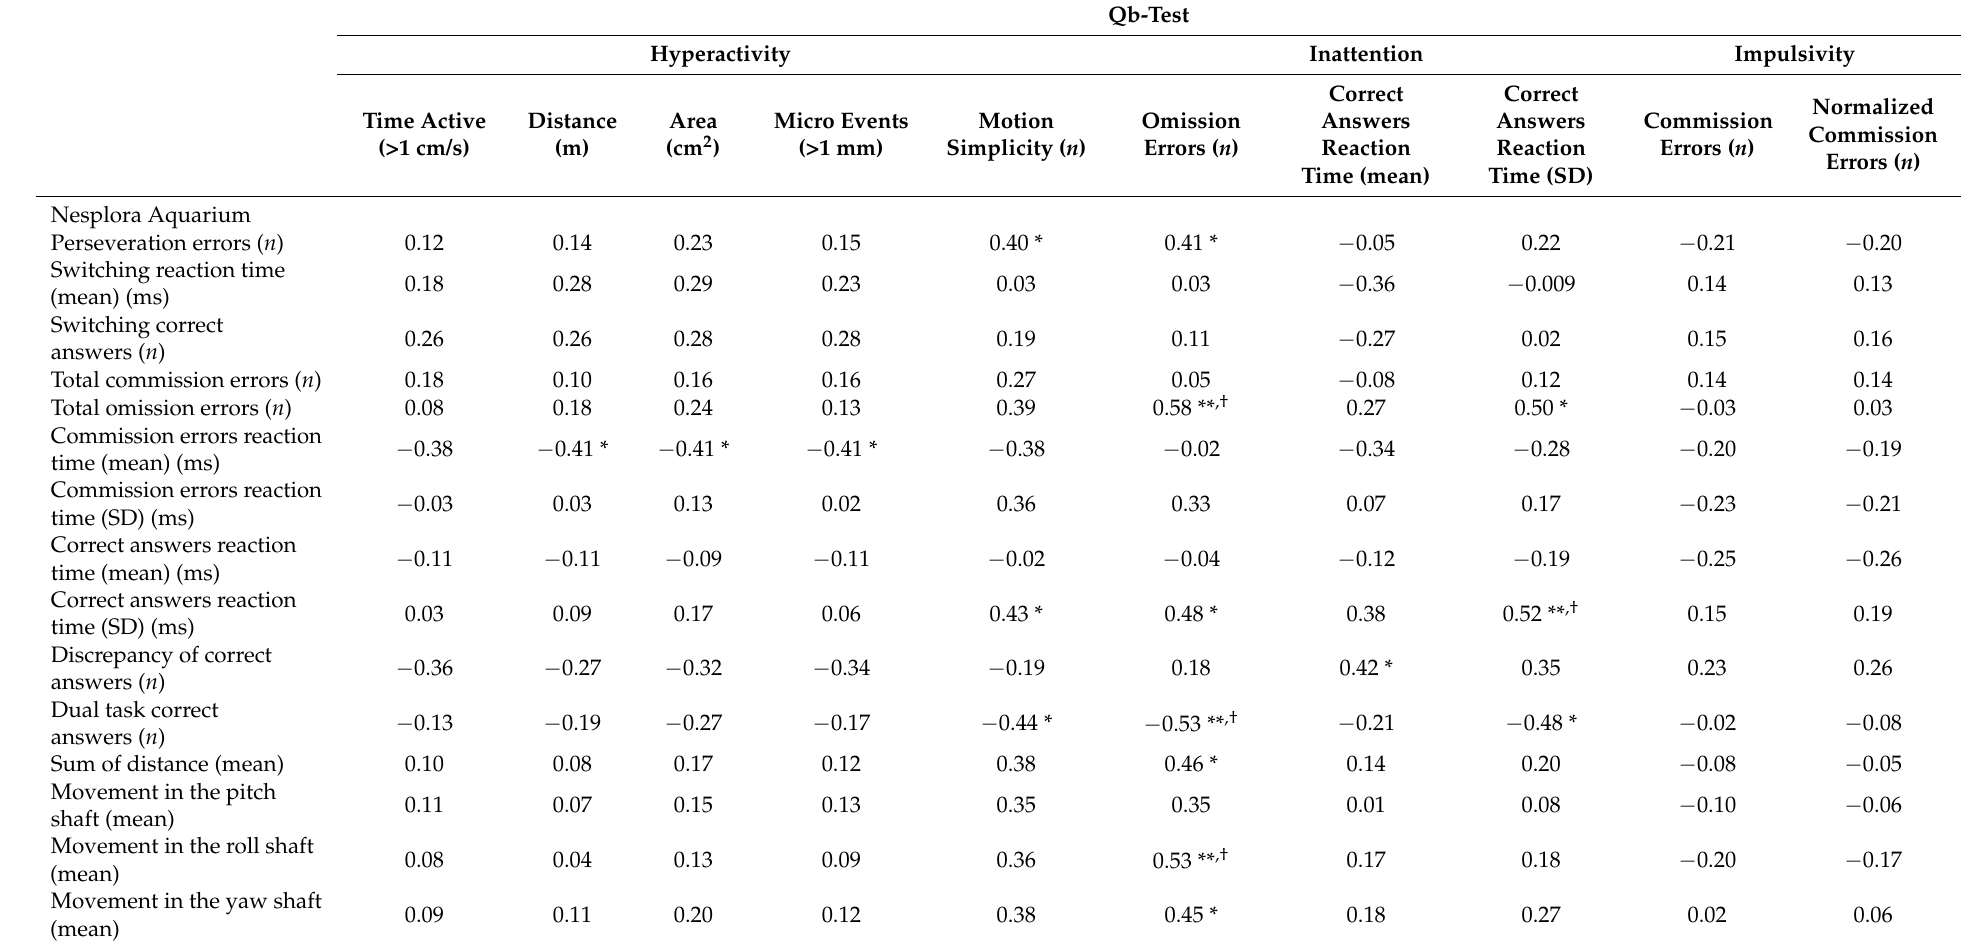
Table 4. Correlations between the underlying variables of the principal components of Nesplora Aquarium and the